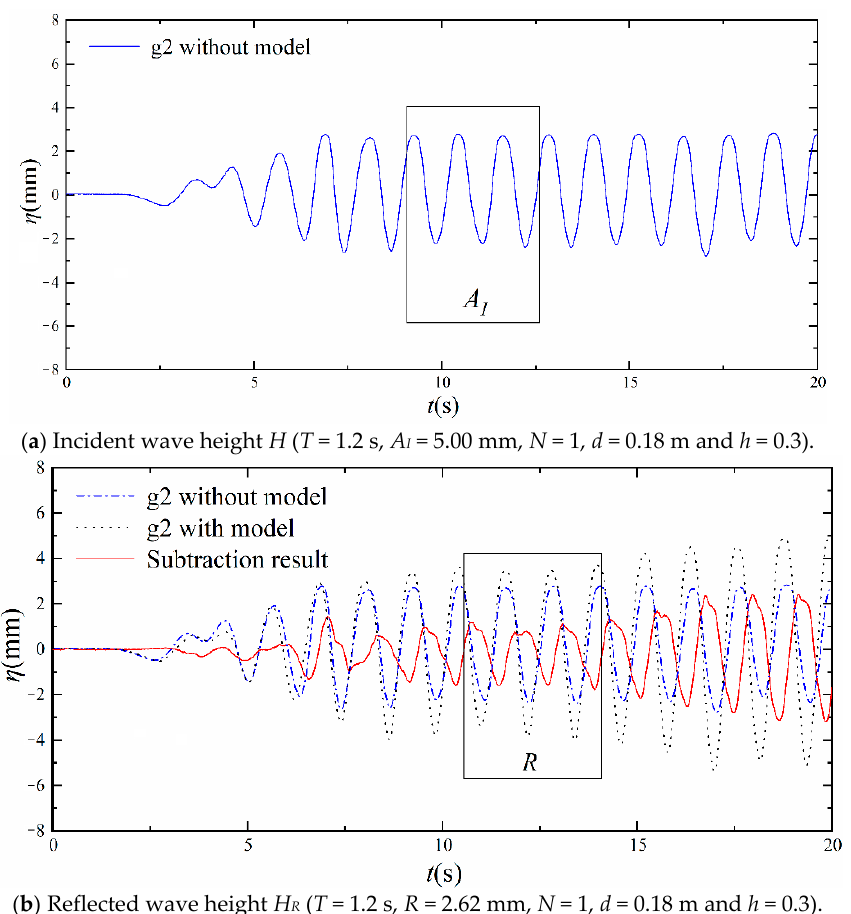
Figure 10. Illustration of the incident wave height H and reflected wave height H R .